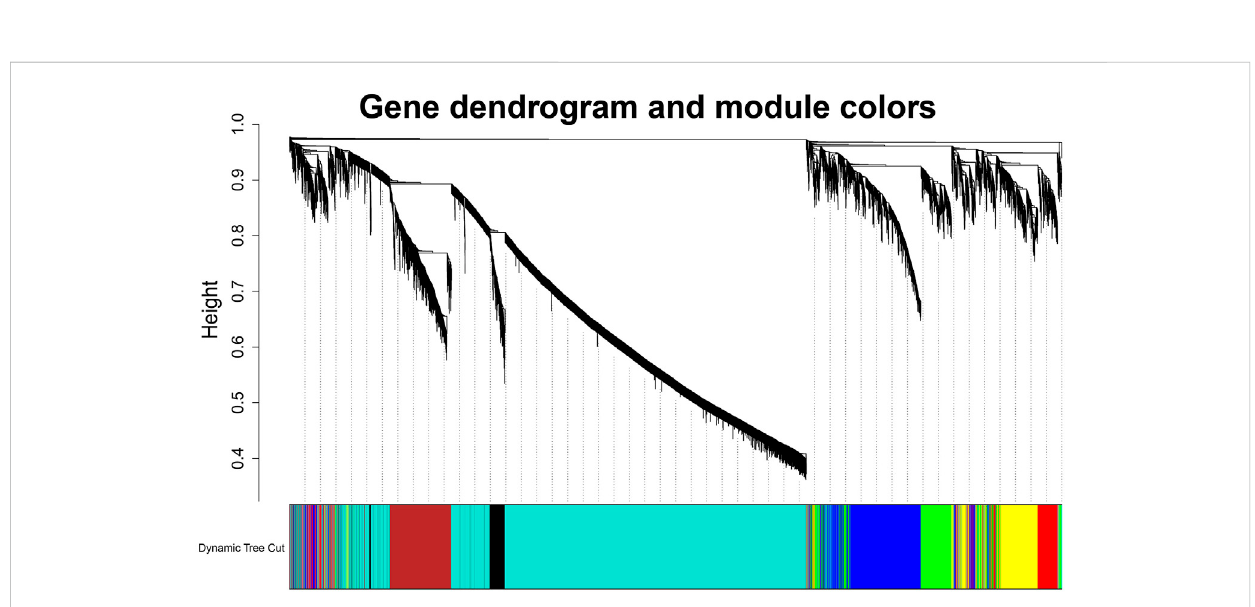
FIGURE 2 Identi fi cationdiagramofgeneco-expressionmodule.Identi fi cationofgeneco-expression modulesviahierarchicalaveragelinkageclustering. The color row underneath the dendrogram shows the module assignment determined by the Dynamic Tree